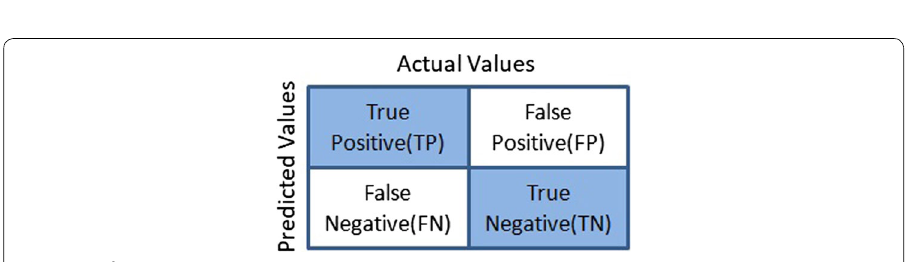
Fig. 5 Confusion